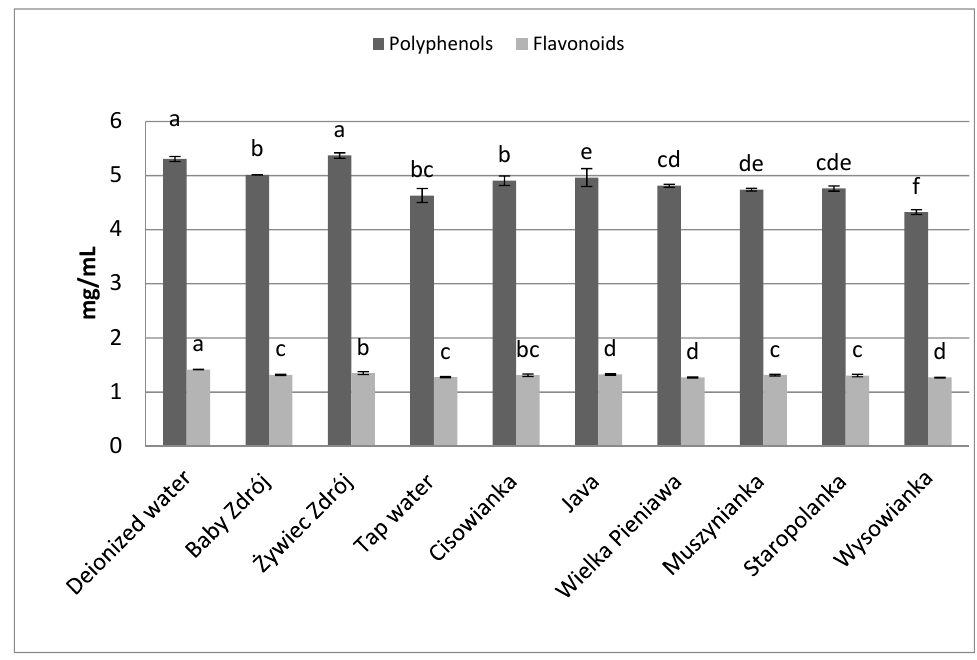
Figure 6. The effect of water mineralization on the extraction of active substances from black tea leaves. Data are shown as mean ± SD. Different letters (a, b, c, etc.) show a significant difference with p < 0.05. The differences relate to each group of compounds separately.